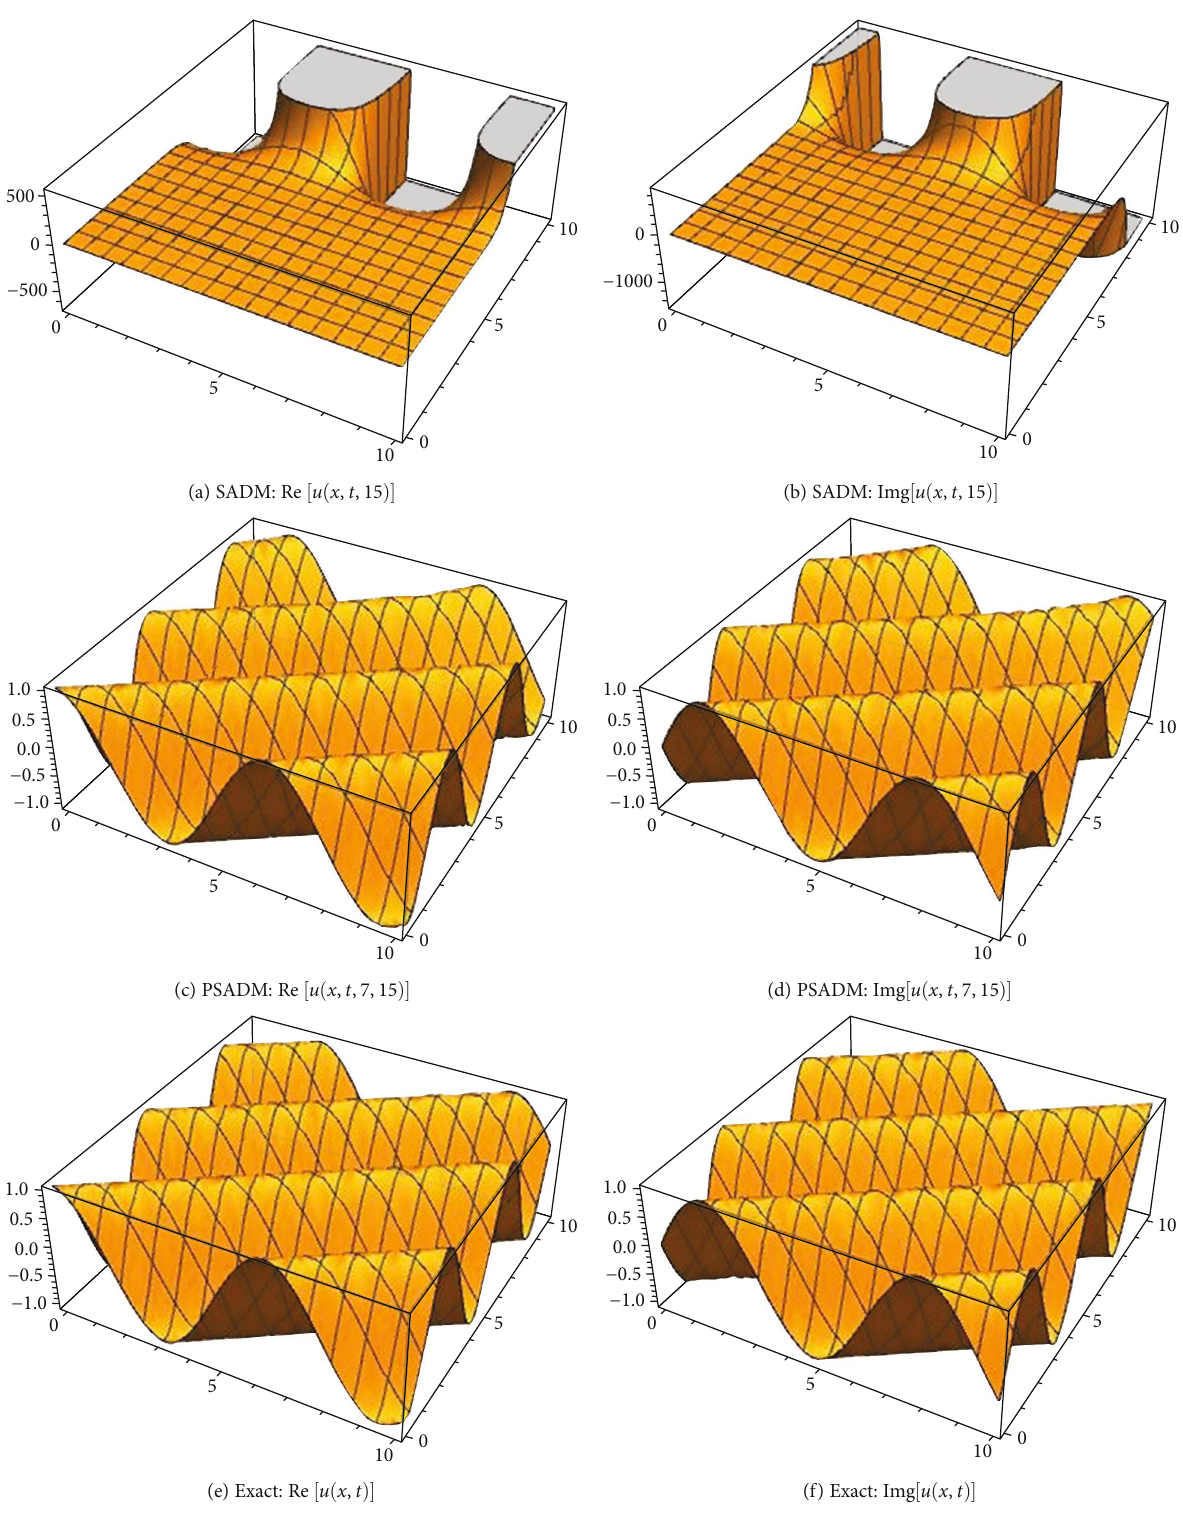
Figure 8: (a – d) SADM and PSADM solutions using 20 terms. (e, f) Exact